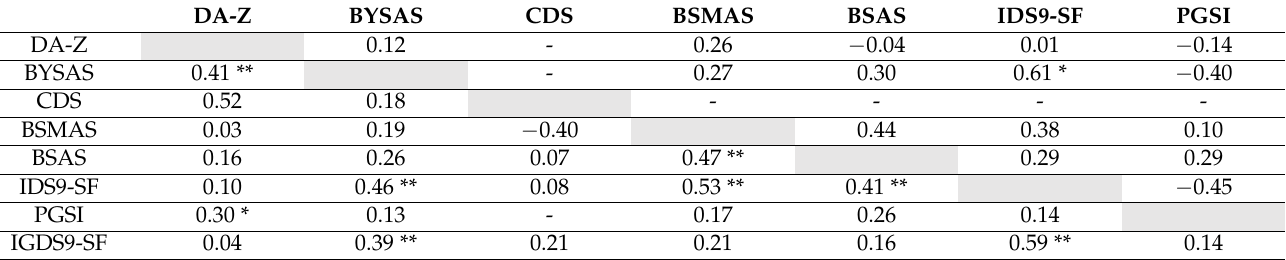
Table 4. Spearman’s rho correlations of non-gamers and gamers in the general